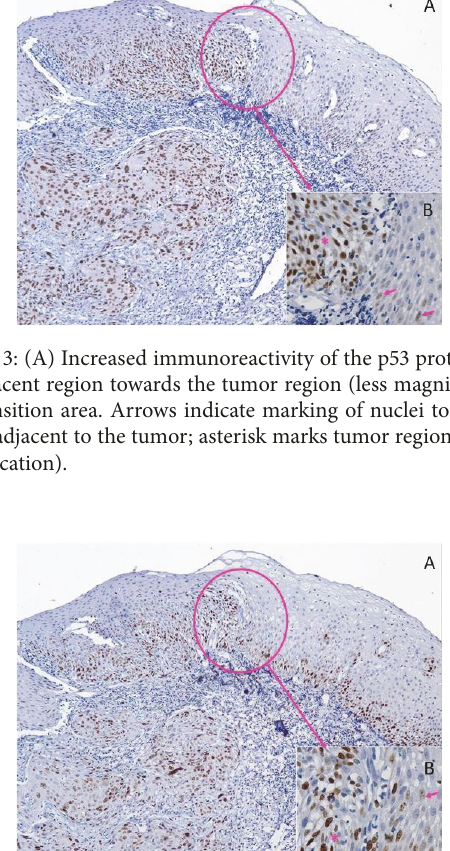
Figure 2: Normal region adjacent to the tumor. Arrows indicate positivity for Ki-67 in some focal areas with poor nuclear marking at the basal layer (200x Magnification).